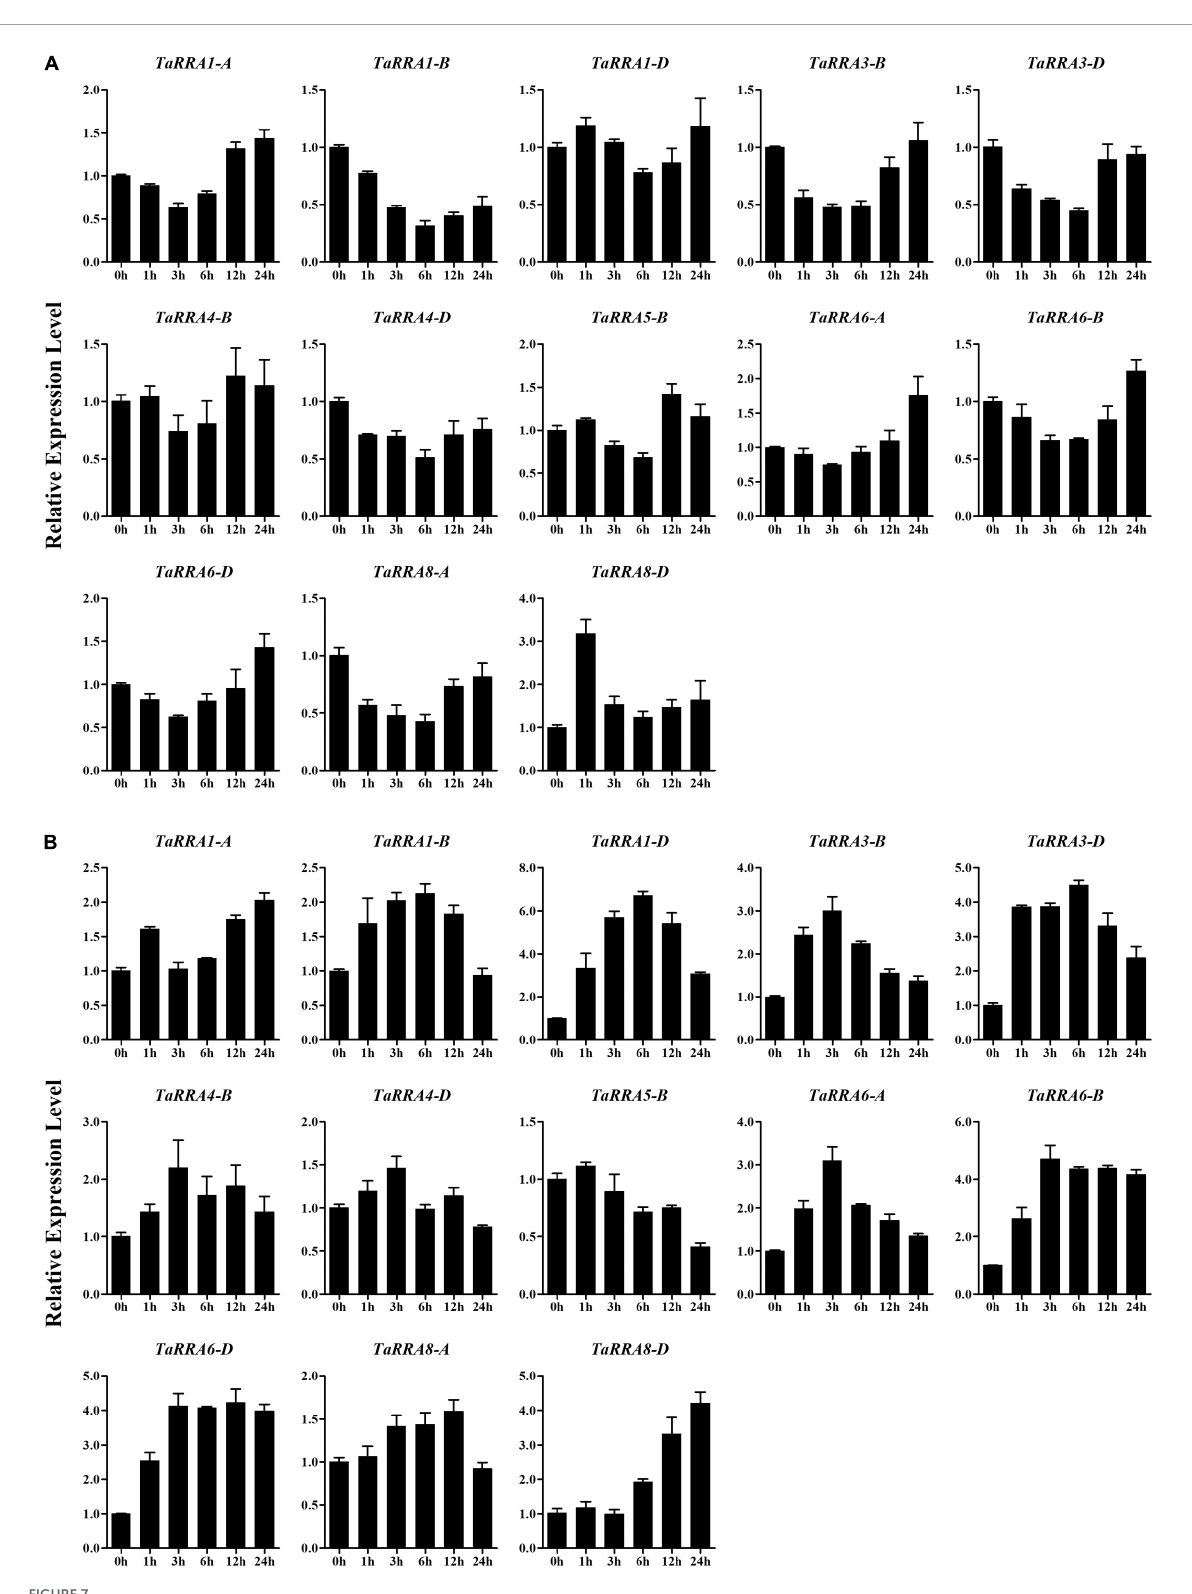
FIGURE7 Quantitative RT-PCR analysis of TaRRA genes under drought and salt stress. Roots of 10-day-old seedlings were sampled after 0, 1, 3, 6, 12, and 24 h drought stress (A) and salt stress (B) . The data are given as means ± SE of three biological replicates.